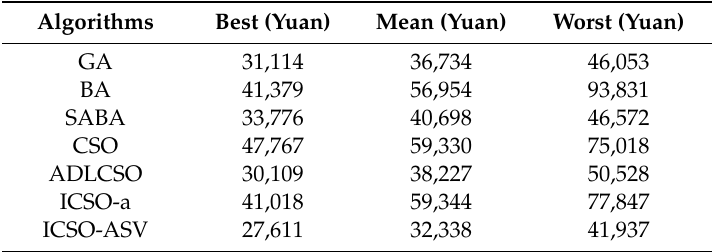
Table 6. Design results of each algorithm (15